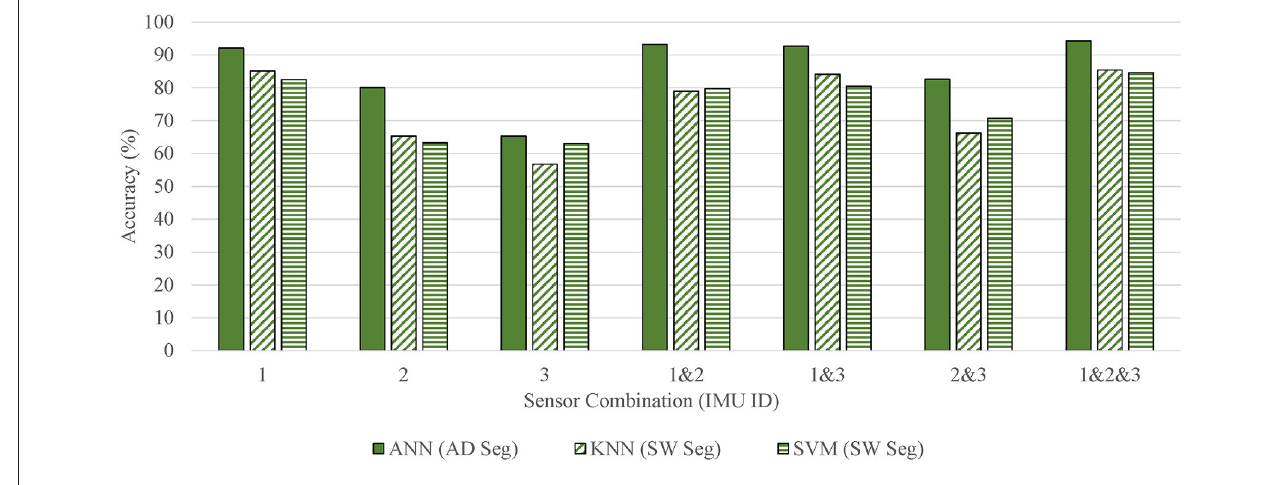
FIGURE 10 | Impact of placement and combination of IMUs on classifiers (LoD9).